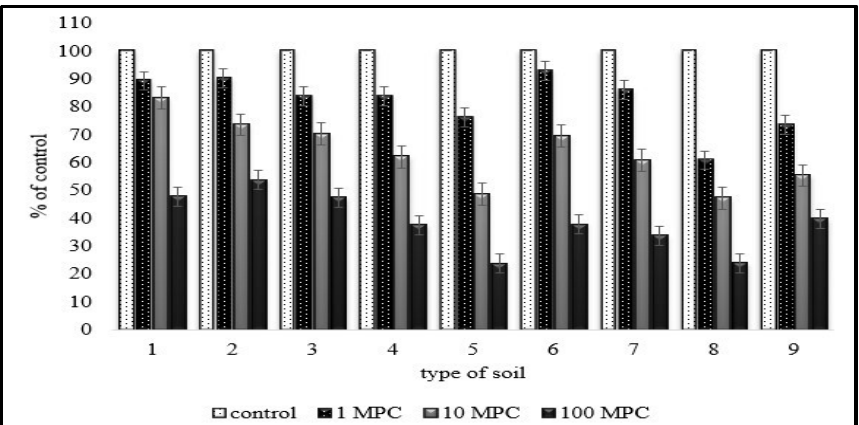
Figure 6. Changes in the integral index of the biological state (IIBS) of forest soils: 1, brown leached soil; 2, brown typical soil; 3, brown carbonate soil; 4, yellow soil; 5, acid brown forest soil; 6, sod- carbonate typical soil; 7, leached sod-carbonate soil; 8, acid brown forest podzolized soil; and 9, Brown forest slightly unsaturated soils.